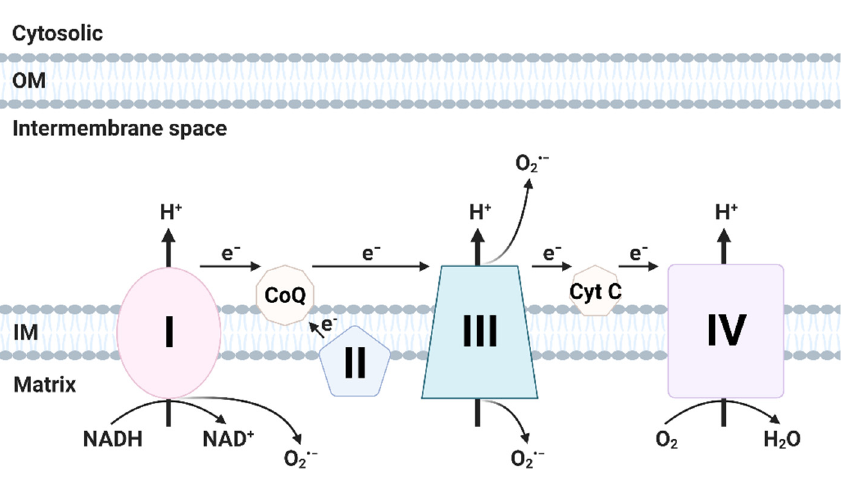
Figure 1. Generation of ROS in electron transport chain (ETC). The ETC is located in the mitochon- drial inner membrane (IM). Complex I and II supply electrons to coenzyme Q (CoQ; ubiquinone). Sequentially, electrons are transferred from CoQ to Complex III, cytochrome c (Cyt c) and Complex IV. Oxidative stress is generated during electron transfer. (Created with BioRender.com accessed on 29 March 2021).